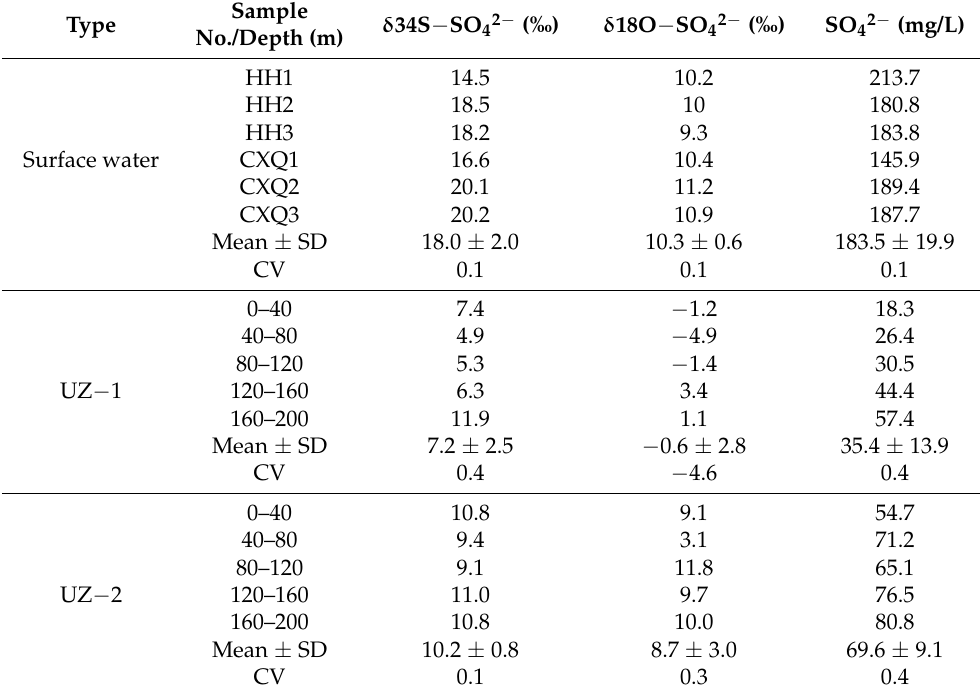
Table 2. Sulfate concentration and sulfur and oxygen isotopic composition of sulfate in the surface water, soil profiles (UZ − 1 and UZ − 2) and